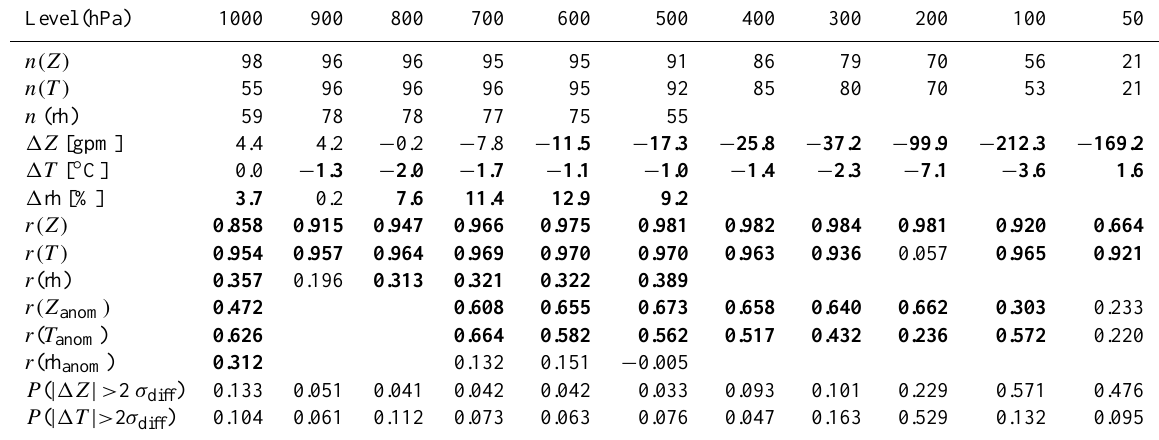
Table 3. Results of the comparison of temperature ( T ), GPH ( Z ), and relative humidity (rH) between observations onboard the MS Schwabenland and 20CR. Subscript “anom” refers to the anomalies from NNR climatology, r is the correlation coefficient, P stands for probability, and P( | 1T | > 2 σ diff ) is the fraction of differences outside the interval ± 2 σ diff